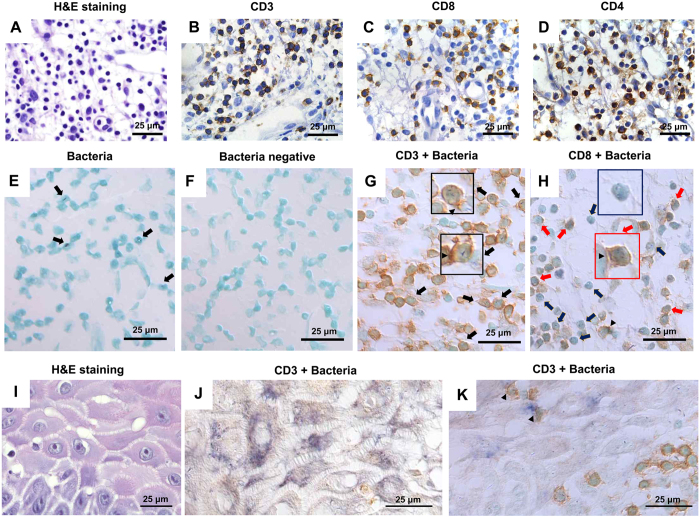
Presence of bacteria within epithelial cells CD3+, CD8+ and CD8− lymphocytes in OLP tissues.Sections of OLP tissues were stained with hematoxylin and eosin (A,I) or immunostained for CD3 (B), CD8 (C), and CD4 (D). Sections of OLP tissues were hybridized in situ for 16S rRNA (E). Arrows indicate bacteria detected within lymphocytes. Sections of OLP tissues were hybridized in situ with a negative probe and then immunostained with an isotype antibody (F). Sections of OLP tissues (n = 4) were hybridized in situ for 16S rRNA and then immunostained for CD3 (G,J,K) or CD8 (H). Black arrows indicate bacteria signals detected within CD3+ cells; red arrows indicate bacteria detected within CD8+ cells; blue arrows indicate bacteria detected within CD8− lymphocytes; arrowheads indicate an immunologic synapse-like structure.